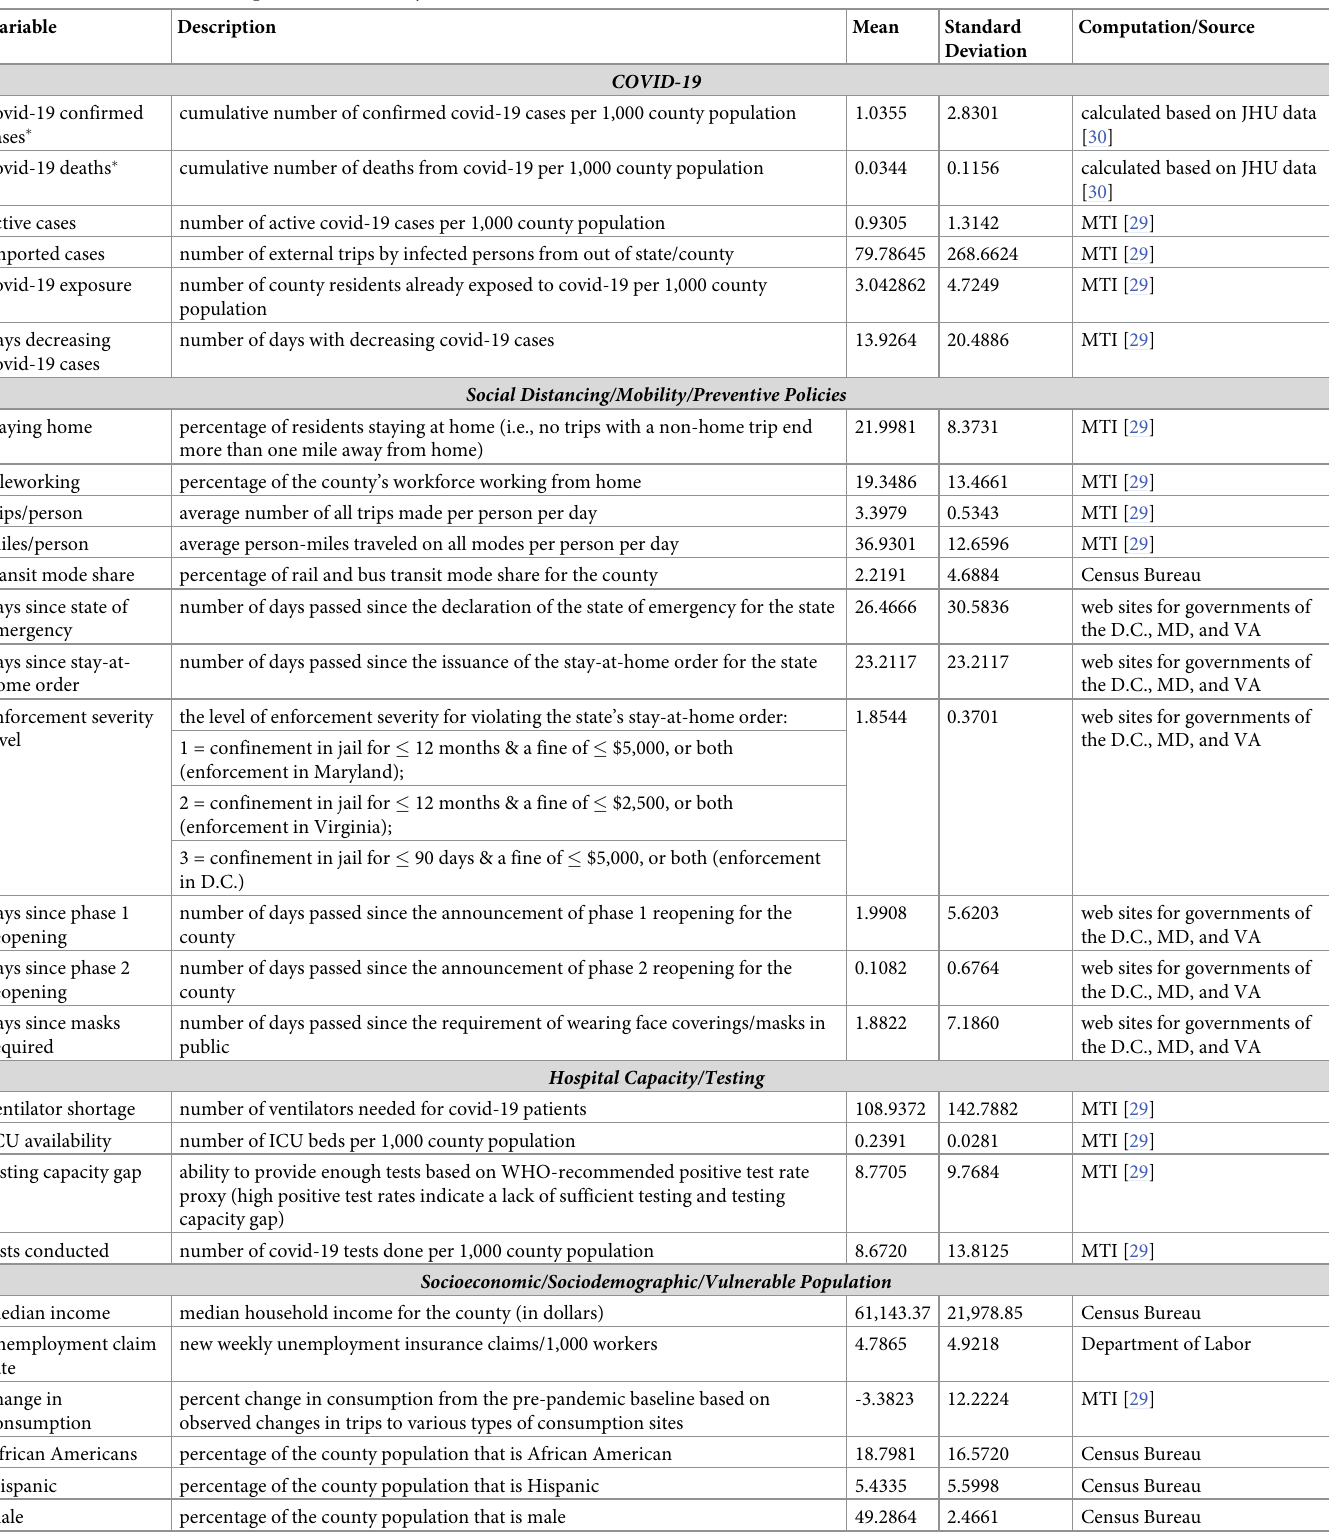
Table 1. Model variables: Descriptions and summary